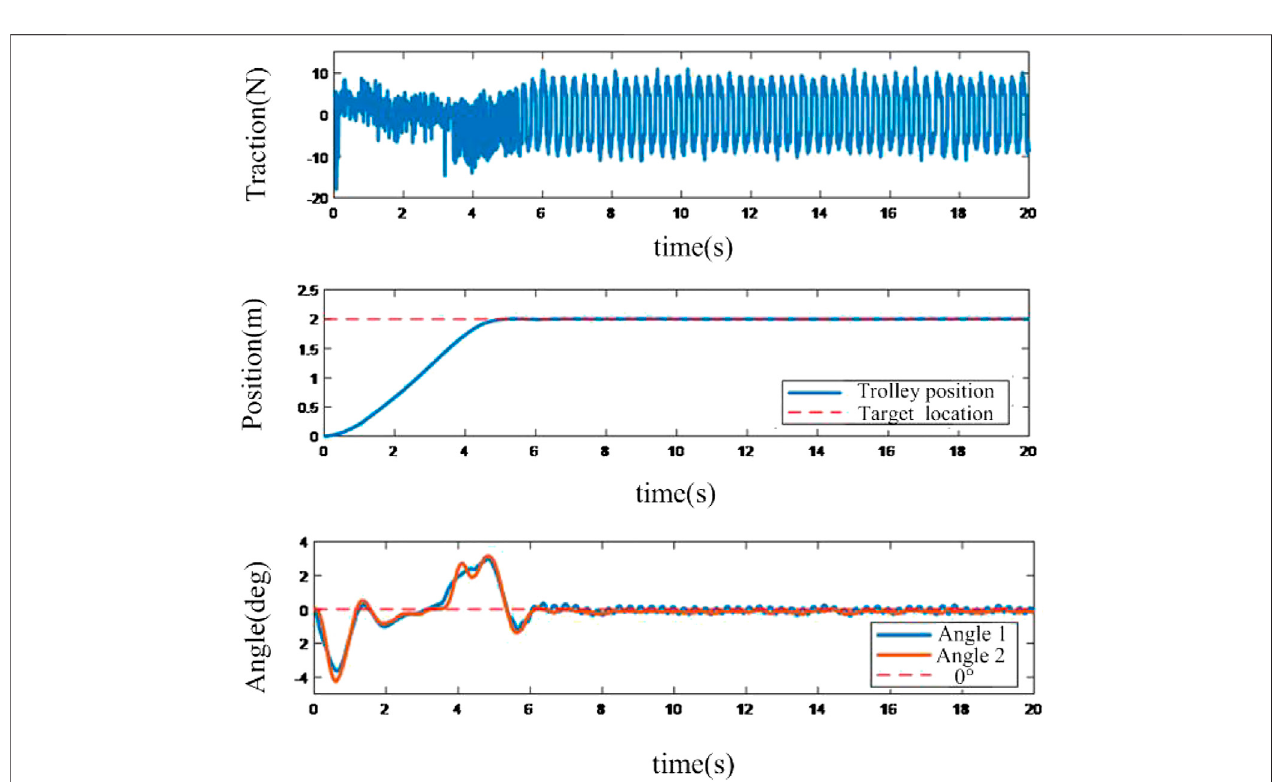
FIGURE 7 | Response of the positioning anti-swing system based on sliding mode method.